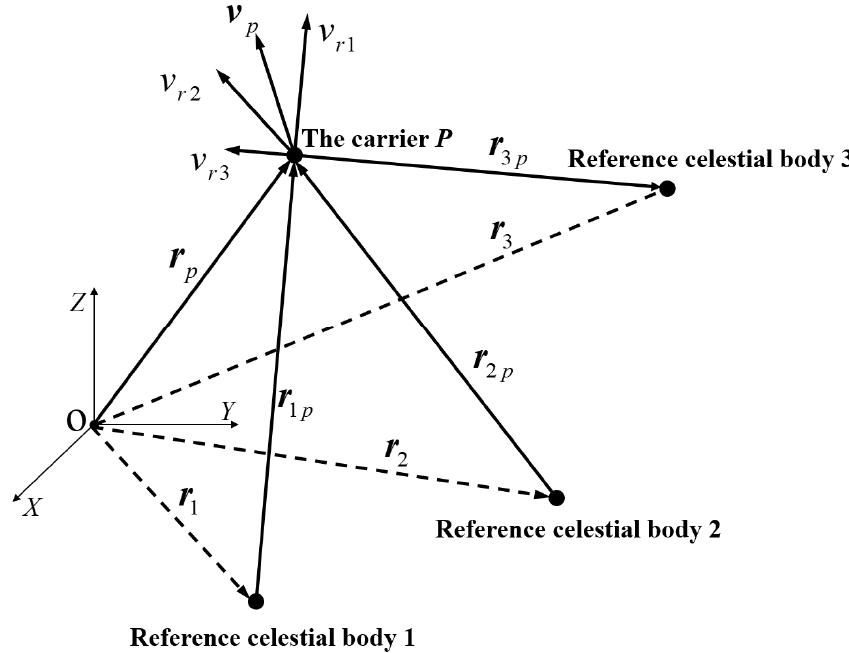
Figure 3. The schematic diagram of spectral redshift navigation, where r 1 , r 2 , r 3 , r p represent the position vectors of celestial body 1, celestial body 2, celestial body 3, and carrier P in the inertial coordinate system, respectively; r 1 p , r 2 p , r 3 p represent the position vectors from three celestial bodies to the carrier; v r 1 , v r 2 , v r 3 are the radial velocities of the carrier relative to three reference celestial bodies; and v p is the velocity vector of the carrier in the i